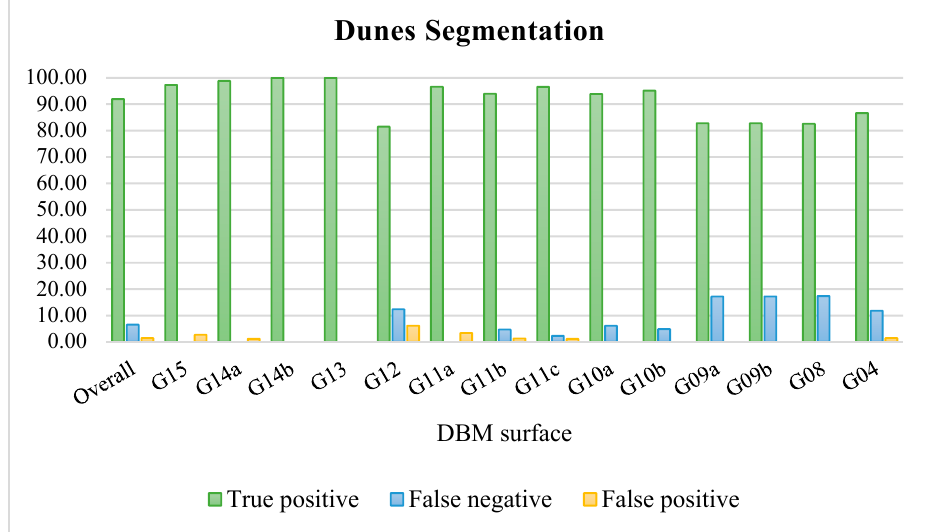
Figure 14. Performance measures of the proposed method, namely true positive, false negative, and false positive rates. Please note that we present the overall performance considering all the surfaces.